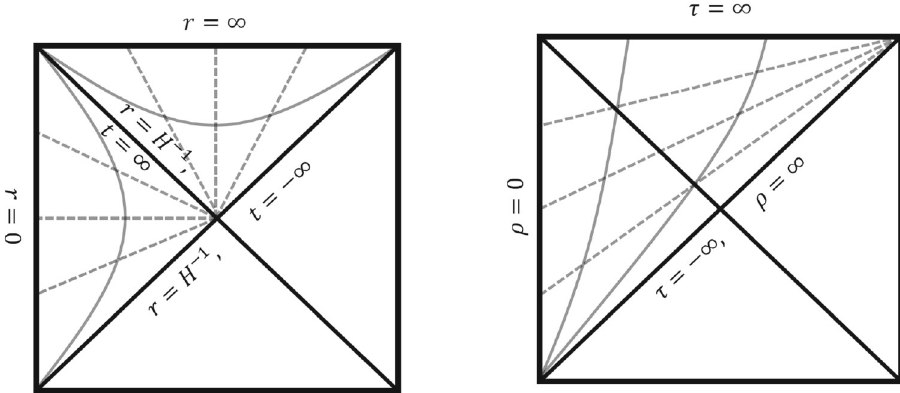
in region II, respectively. The flat coordinates cover the inflating patch, the union of regions I and II, without the coordinate singularity, as can be seen in the right panel of Fig.